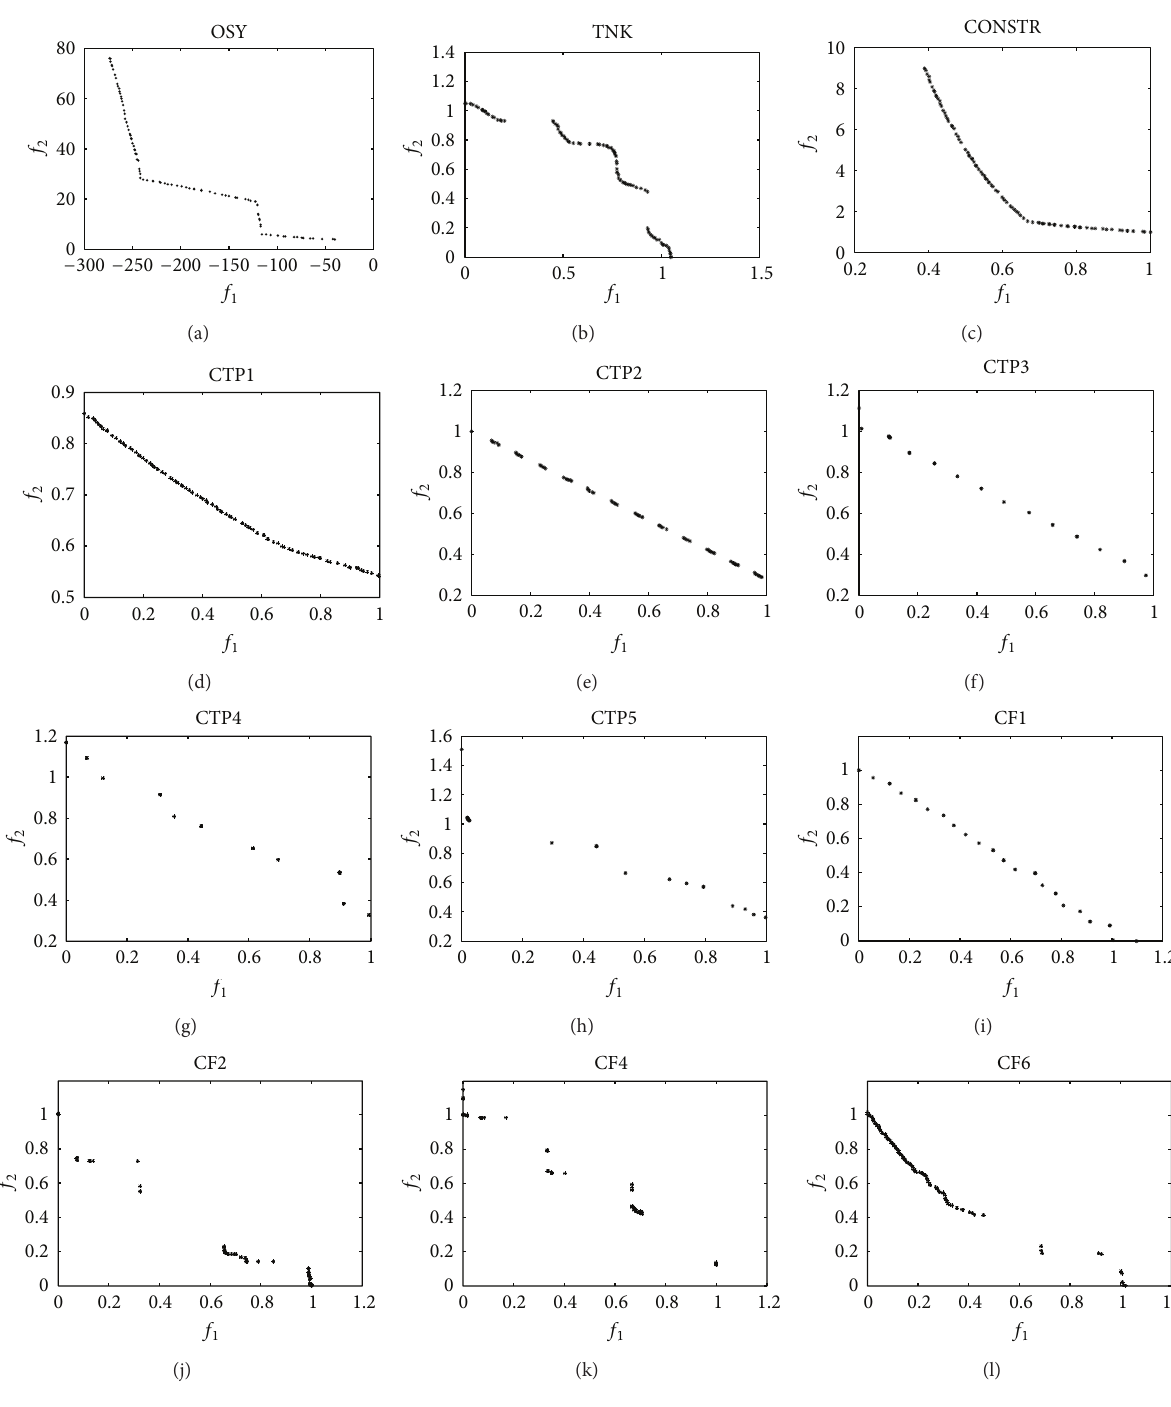
Figure 1: Final Pareto front for all test functions by the proposed algorithm CMBOA.